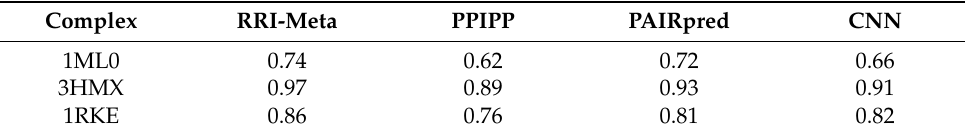
Table 2. AUROCs of RRI predictors in case study.